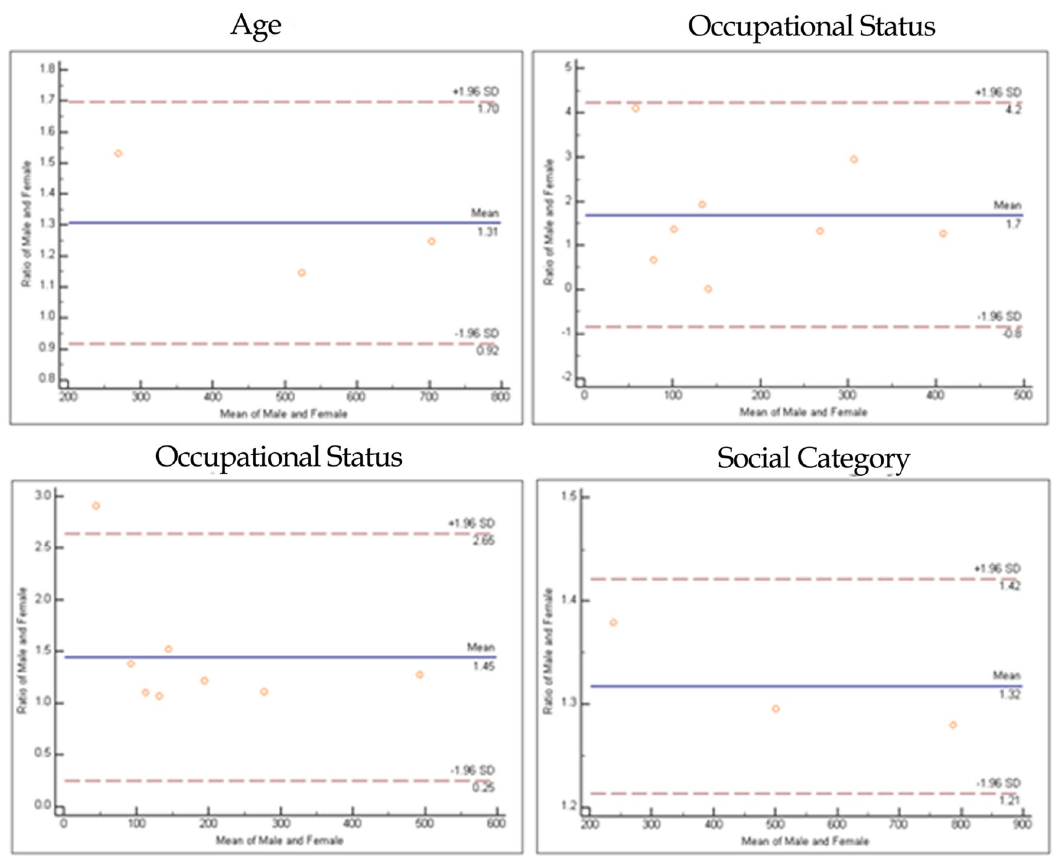
Fig 3. Bland-Altman plot of demographic characteristics of the sentinel sites.